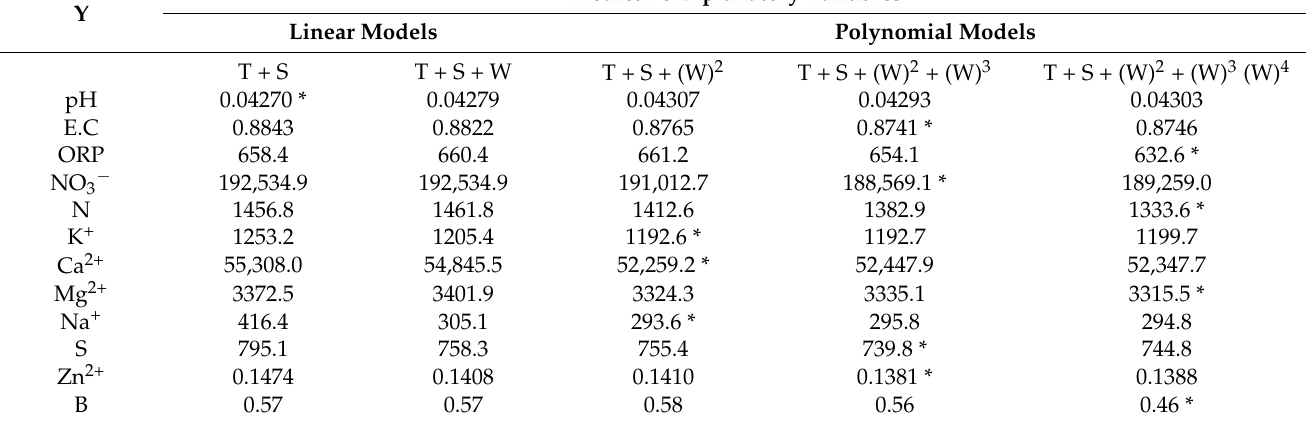
Table 5. Error coefficients obtained by a cross-validation method for the different subsets of the explanatory variables as well as for the different polynomial grades performed in the numerical